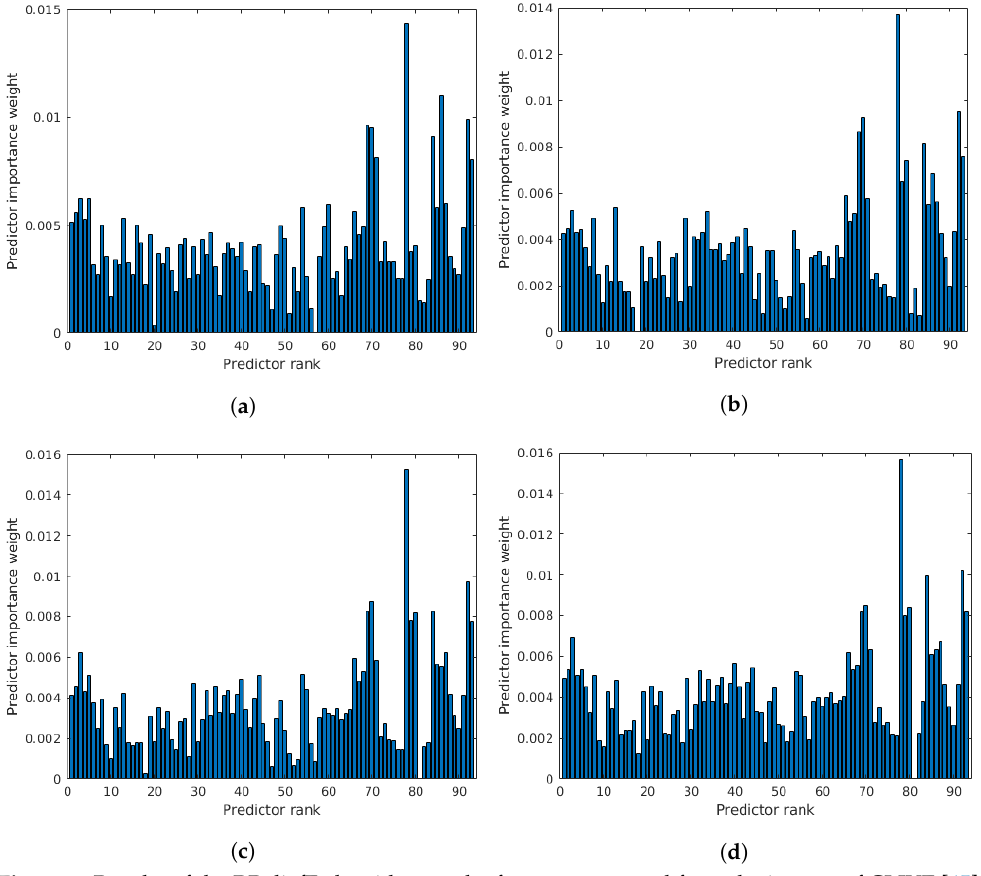
Figure 5. Results of the RReliefF algorithm on the features extracted from the images of CLIVE [45]. ( a ) k = 1 nearest neighbours, ( b ) k = 3 nearest neighbours, ( c ) k = 5 nearest neighbours, ( d ) k = 7 nearest